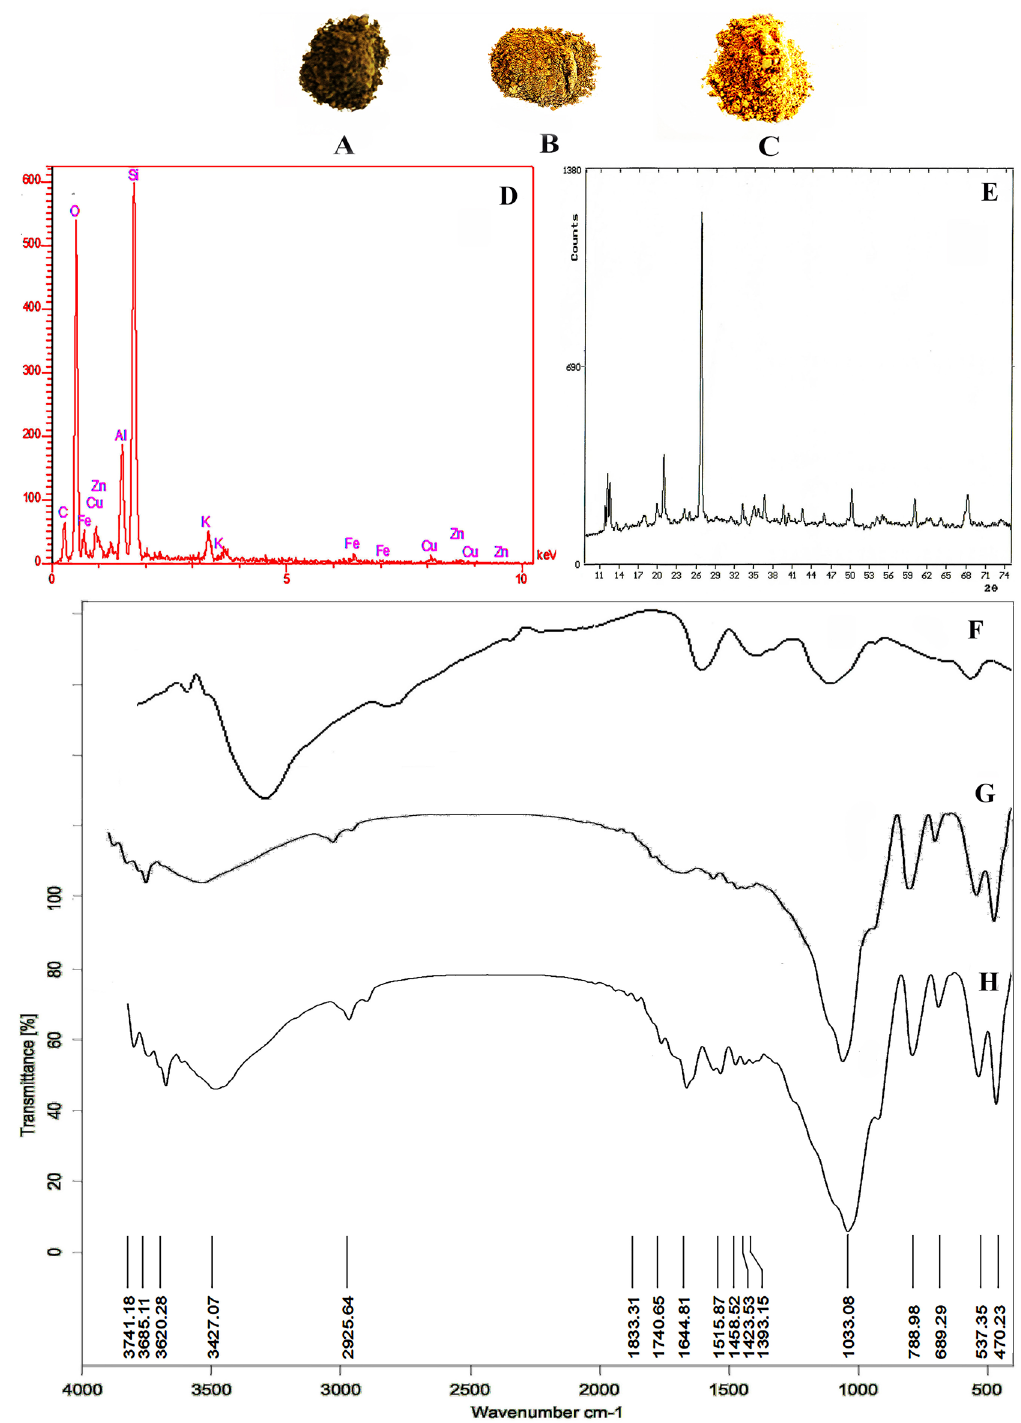
Figure 1. The physical form of ( A ) Mlt; ( B ) ZnO/Mlt-NC; ( C ) ZnO/Mlt/Chsn-NC; ( D ) EDX pattern of ZnO/ Mlt-NC; ( E ) XRD diffractogram of ZnO/Mlt-NC; FTIR patterns of ( F ) Chsn; ( G ) ZnO/Mlt-NC; ( H ) ZnO/Mlt/